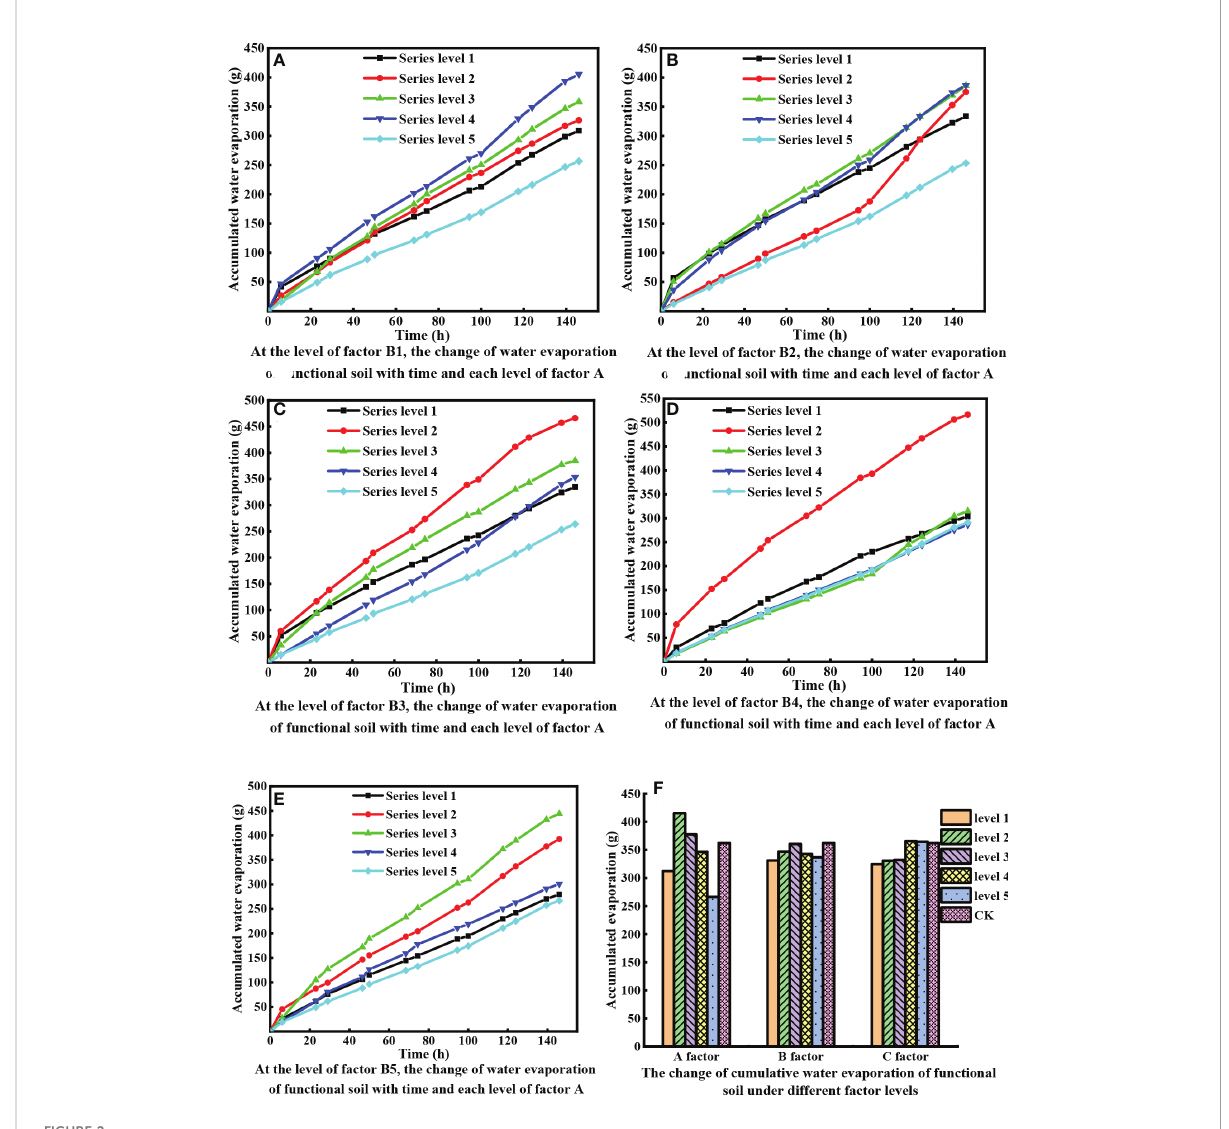
FIGURE 2 Evaporation characteristics of the functional